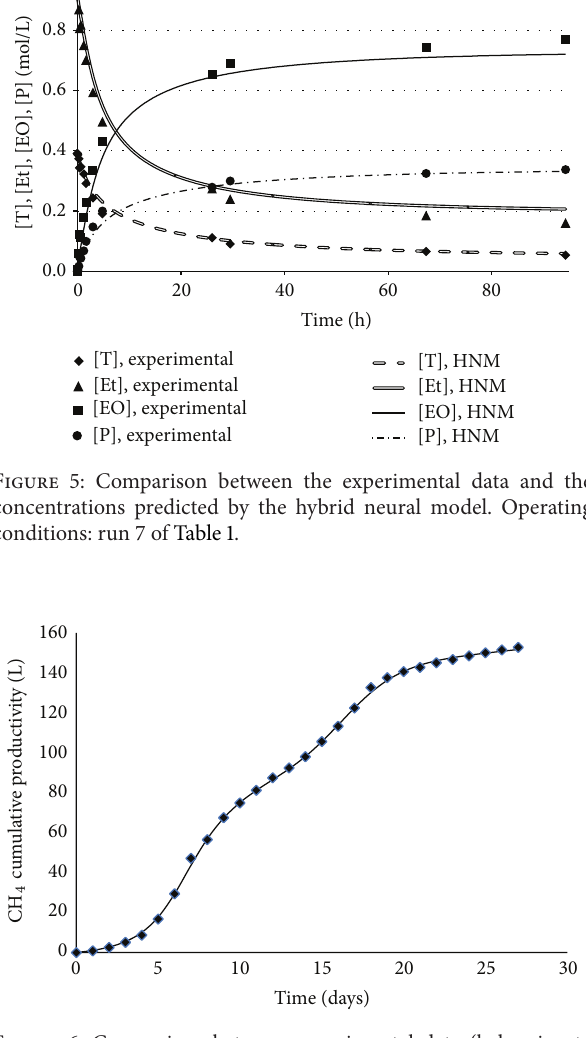
Figure 6: Comparison between experimental data (belonging to the test/training dataset) and methane cumulative productivity as predicted by the ANN 2 . Operating conditions: run 4 of Table 2.